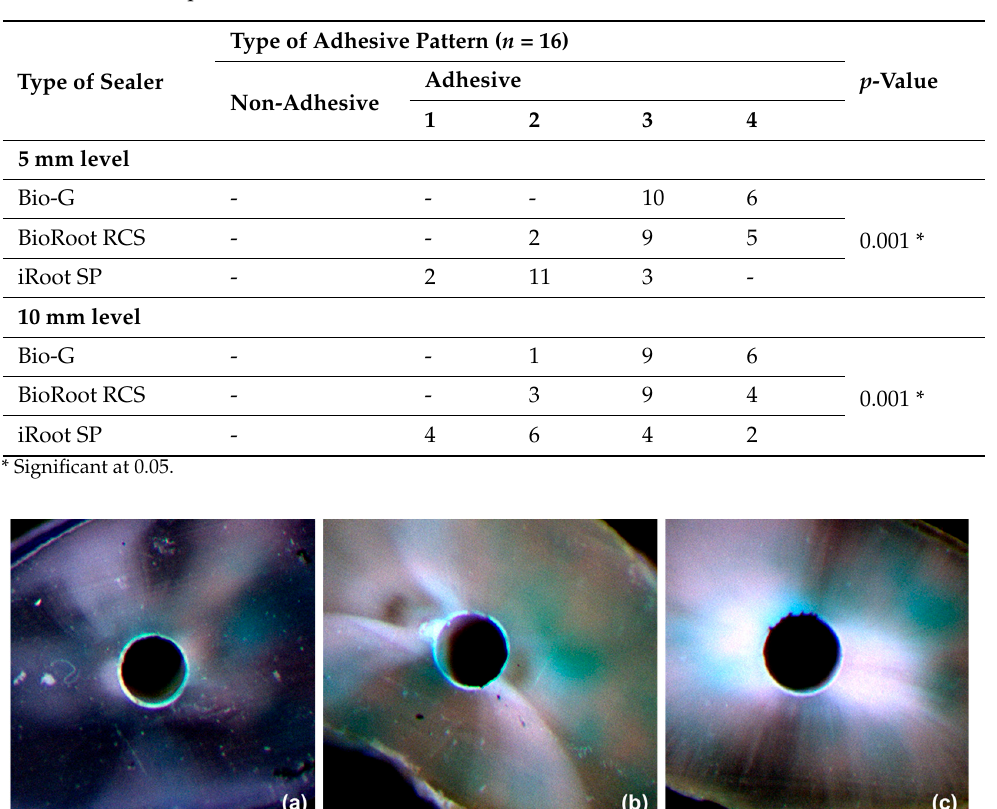
Table 2. Adhesive pattern of Bio-G, BioRoot RCS, and iRoot SP.